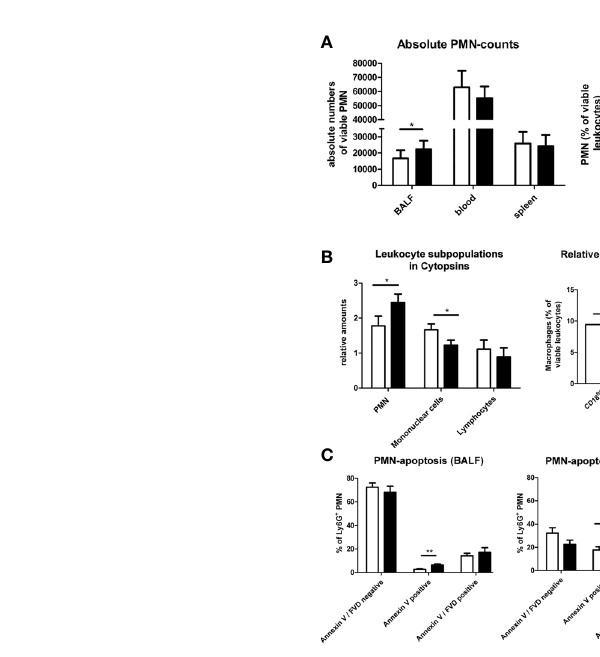
FIGURE 5 | CD18 Ly6G cKO mice infected with A. fumigatus are characterized by elevated lung in fi ltration of PMN, but not in spleens and blood (n=10/genotype) (A) . Elevated PMN counts have also been found in Cytospins (bars depict the mean ± SEM of n=8 cytospins/genotype; cell in fi ltration has been assessed using a scoring system; 0=missing - 3=strongest in fi ltration) (B) . Here, we could additionally observe higher numbers of mononuclear cells (B) . This is consistent with the fi nding of higher macrophage counts in the BALF of CD18 fl / fl mice as compared to CD18 Ly6G cKO mice observed in FACS-analysis (B) . Assessment of PMN apoptosis revealed a stronger expression of apoptosis marker Annexin V in PMN derived from BALF and blood of CD18 Ly6G cKO mice (C) . Bars depict the mean ± SEM of the relative cell counts found in n=8 cytospins/genotype. Legend in A applies to all panels. Statistically signi fi cant differences between groups are indicated